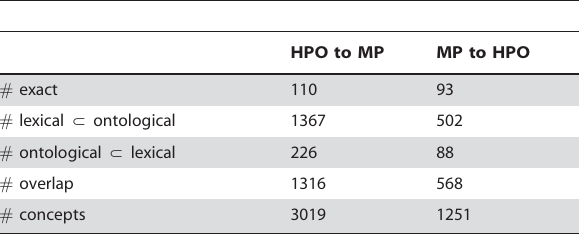
Table 1. Illustrates the amount of mappings falling into each of the overlap categories when both methods are compared.